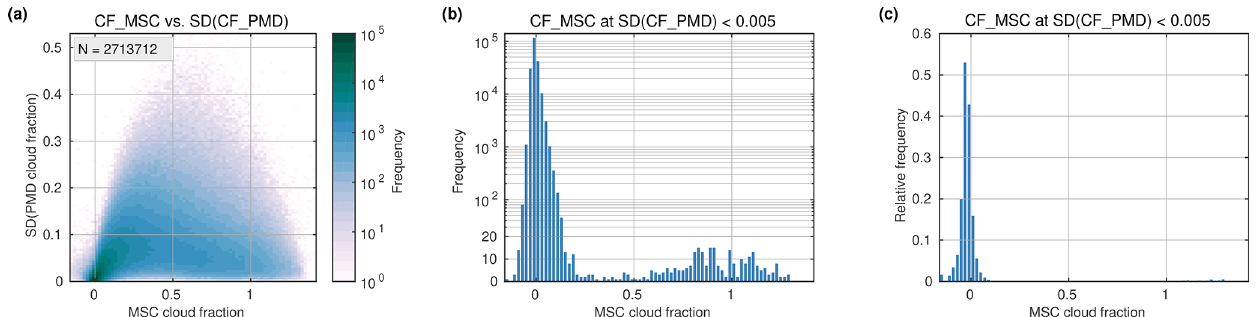
Figure 17. Standard deviation (SD) of PMD cloud fractions within one collocated MSC pixel recorded in April 2010. PMD cloud fractions are obtained from PMD-PP channel 10 ( m = 1) with minimal spatial aliasing to MSC channel 10, which are both centred at 516.7nm. (a) Density of PMD standard deviation and MSC cloud fraction; (b) histogram of MSC cloud fraction for a standard deviation of the collocated PMD measurements < 0.005 that is the lowermost row in panel (a) ; (c) relative frequency corresponding to panel (b) . Note that the lower part of panel (b) is in linear scale; the upper part is in logarithmic scale.